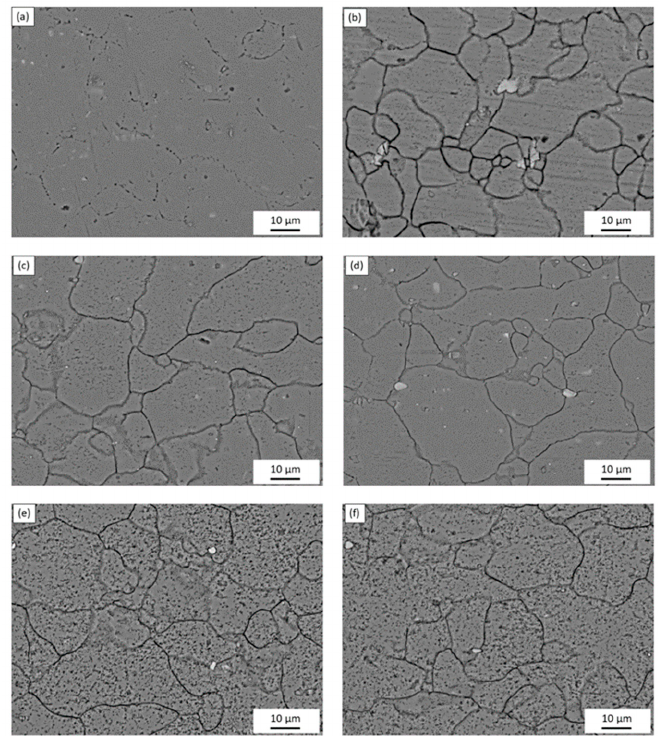
Figure 2. SEM micrographs of AA5083 etched with acidified 0.4 M ammonium persulfate for the ( a ) as-received specimen and AA5083 sensitized at 150 °C for ( b ) 2 days, ( c ) 7 days, ( d ) 14 days, ( e ) 21 days and ( f ) 30 days.